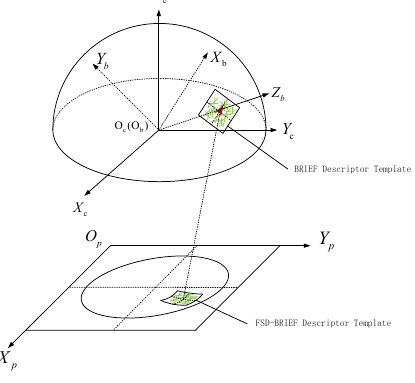
Figure 7. General view of FSD-BRIEF